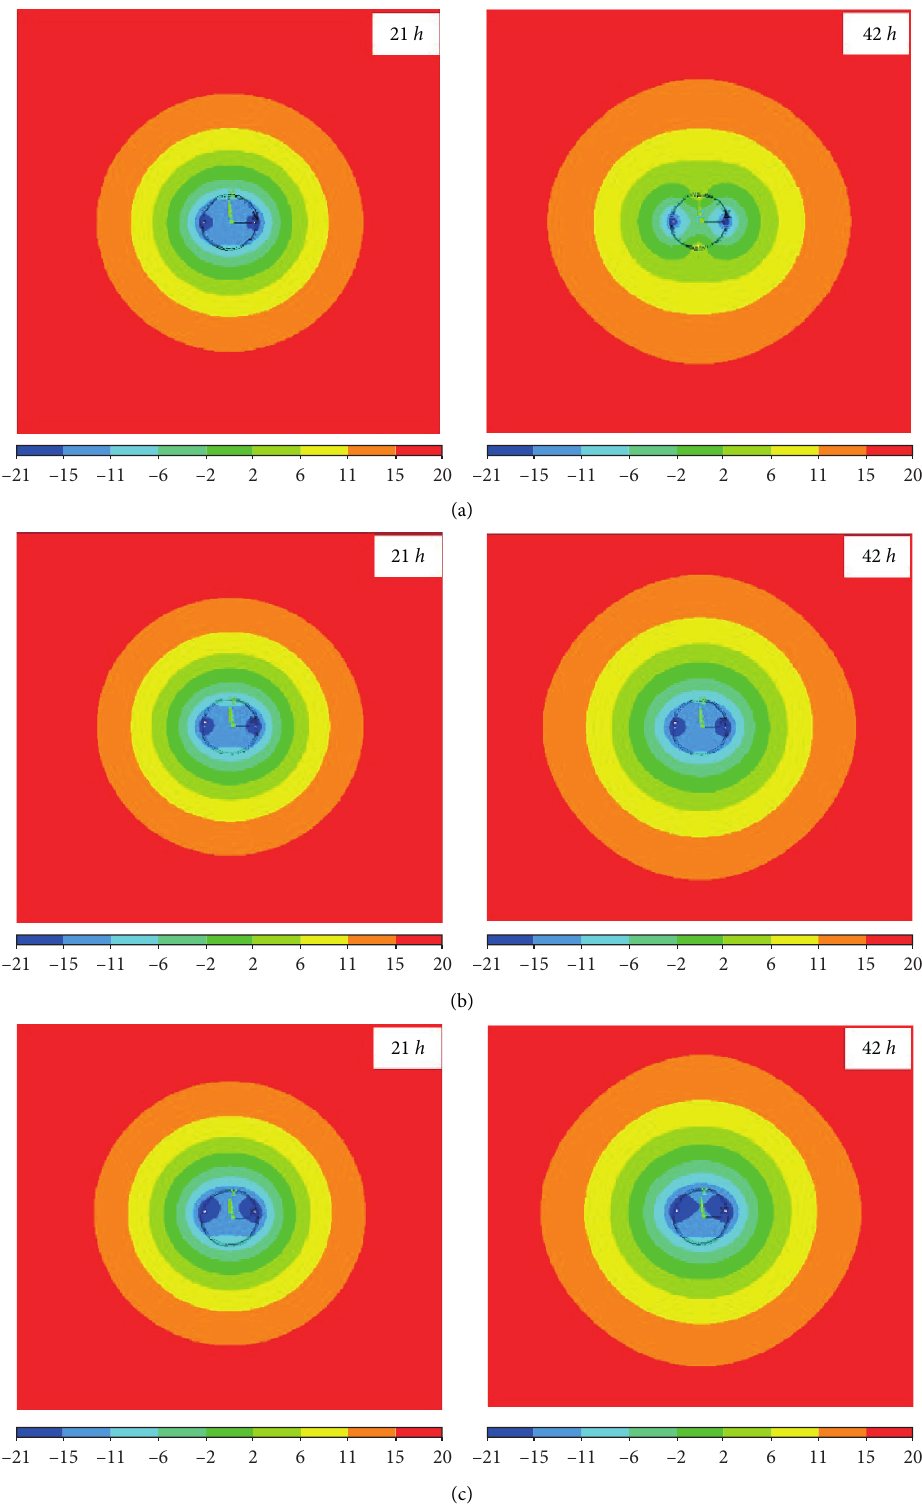
Figure 14: Freezing temperature field: (a) SCF; (b) EDCF; (c)